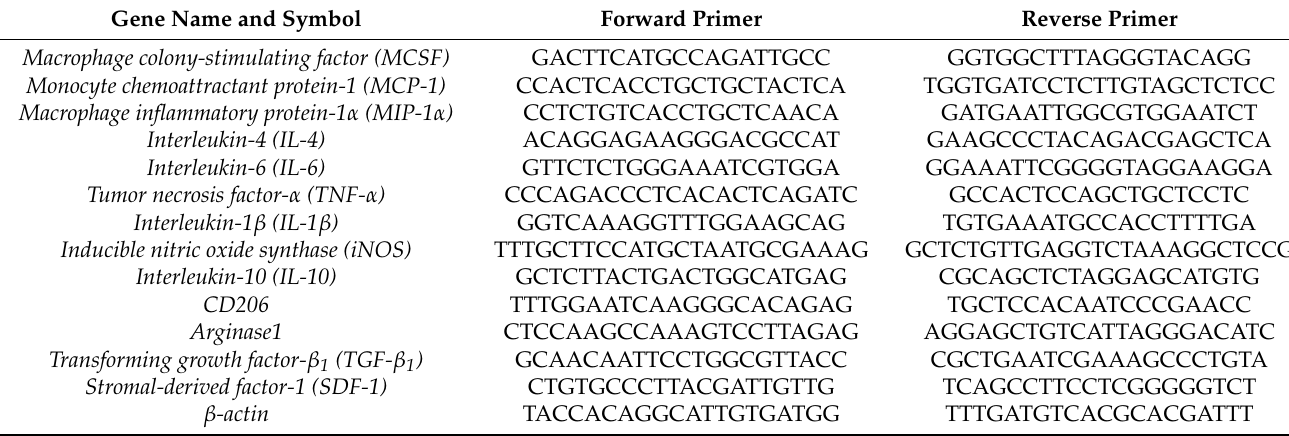
Table 1. Gene names and primer sequences used in this